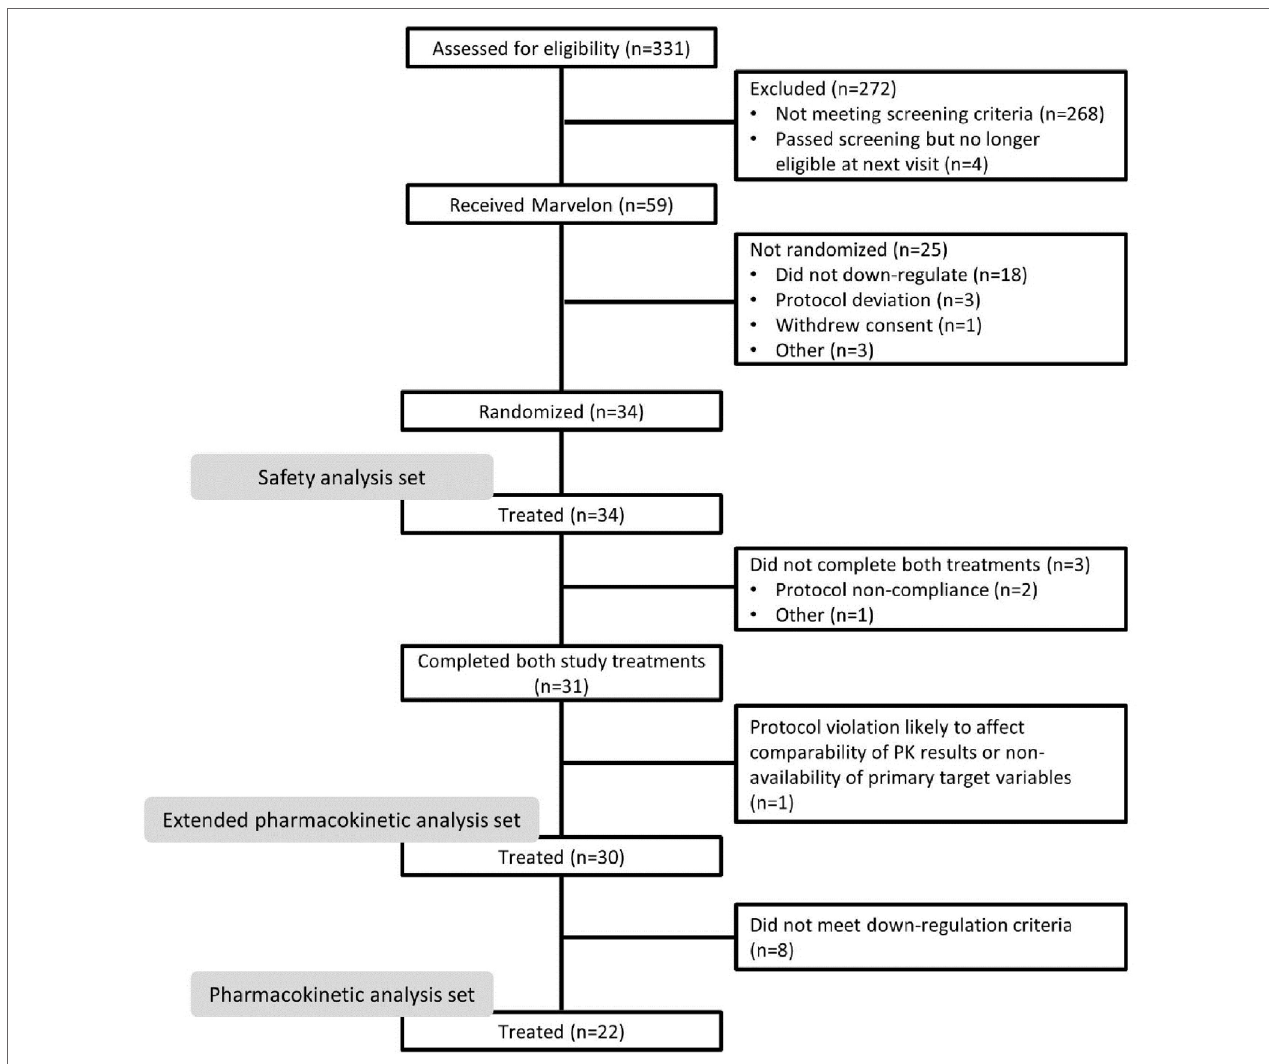
FigUrE 2 | CONSORT flow diagram.